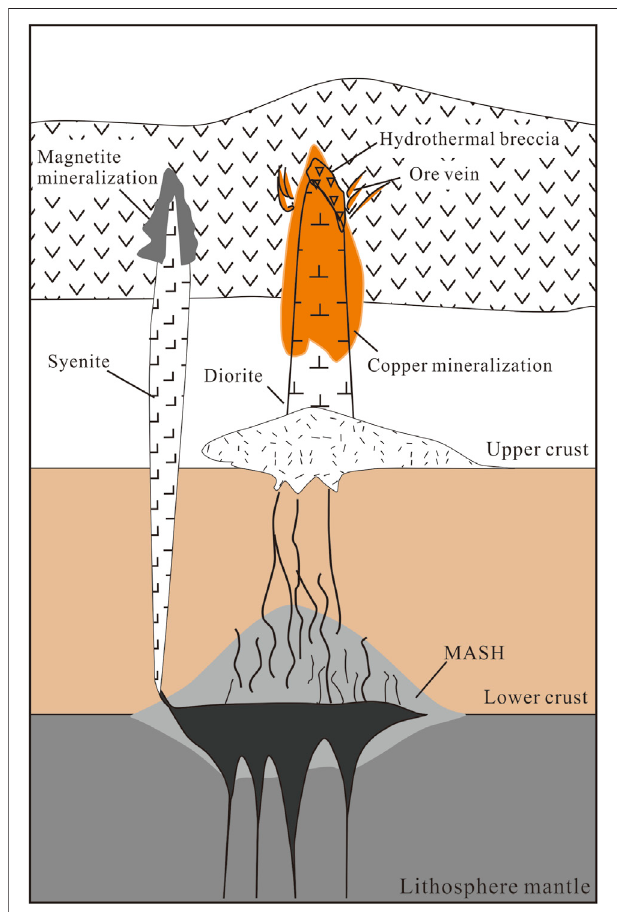
FIGURE 11 | Visualization of the MASH zone at the base of the crust, where hot, dense, ma fi c magmas pool and interact with crustal rocks to generate less dense, hybrid, andesitic – dacitic magmas, minor ma fi c magma will ascend, then exist in the form of syenites with an intense skarn alteration and magnetite mineralization. Andesitic – dacitic magma after MASH will enhance copper mineralization.